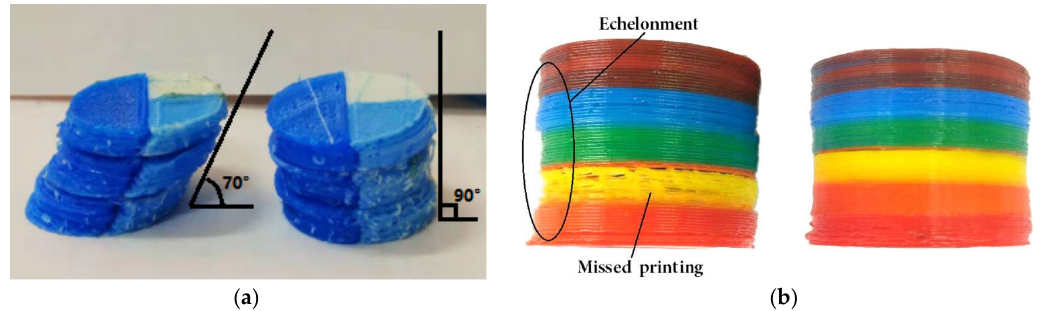
Figure 14. Comparison of printing accuracy before and after optimization: ( a ) results of model 1; ( b ) results of model